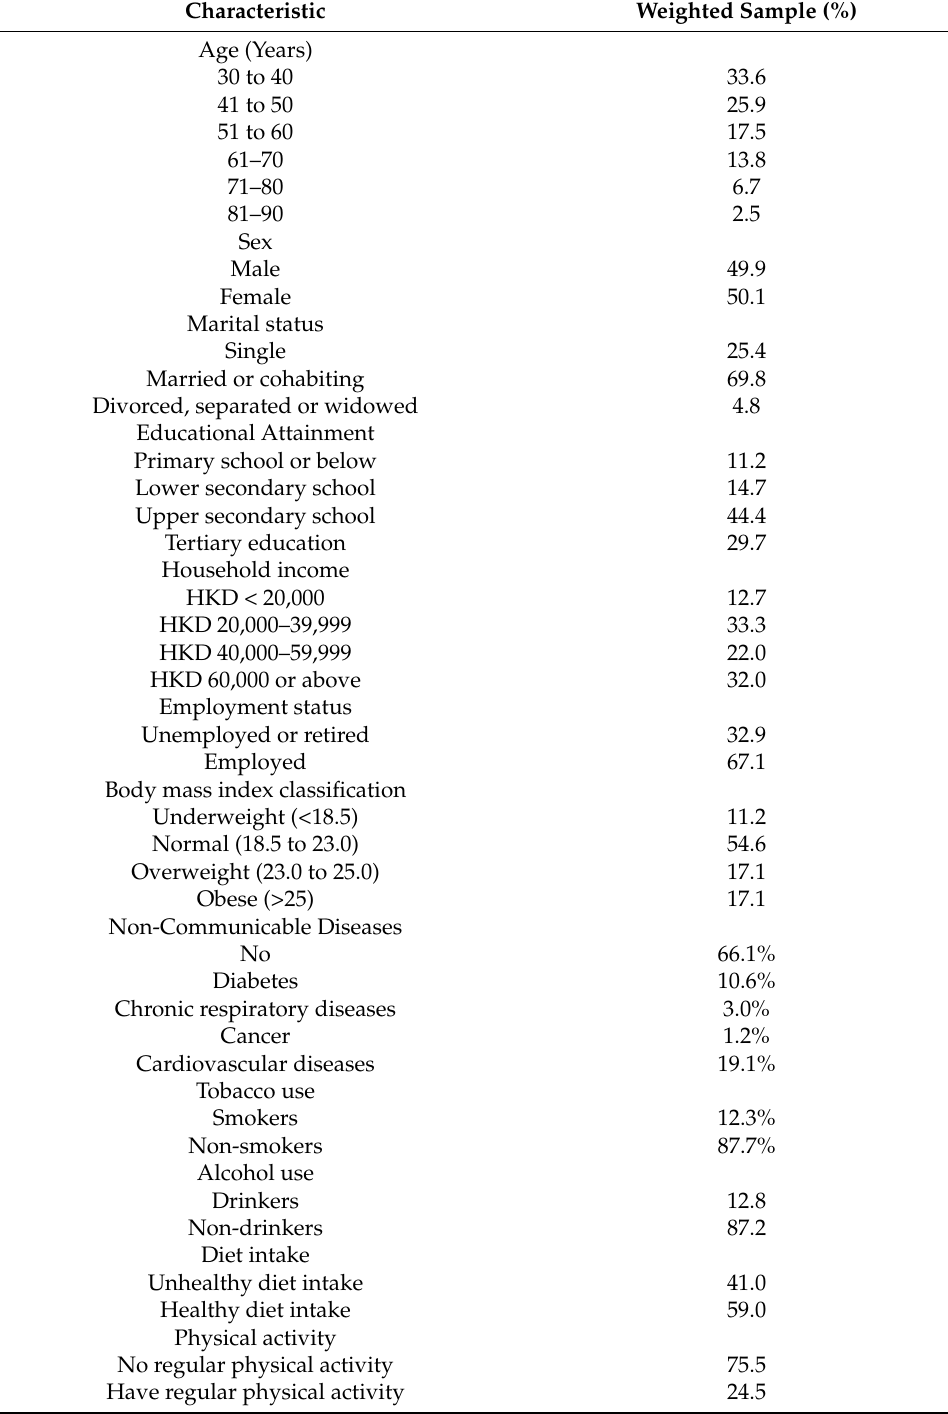
Table 2. Demographic characteristics of the participants ( N = 5737) a